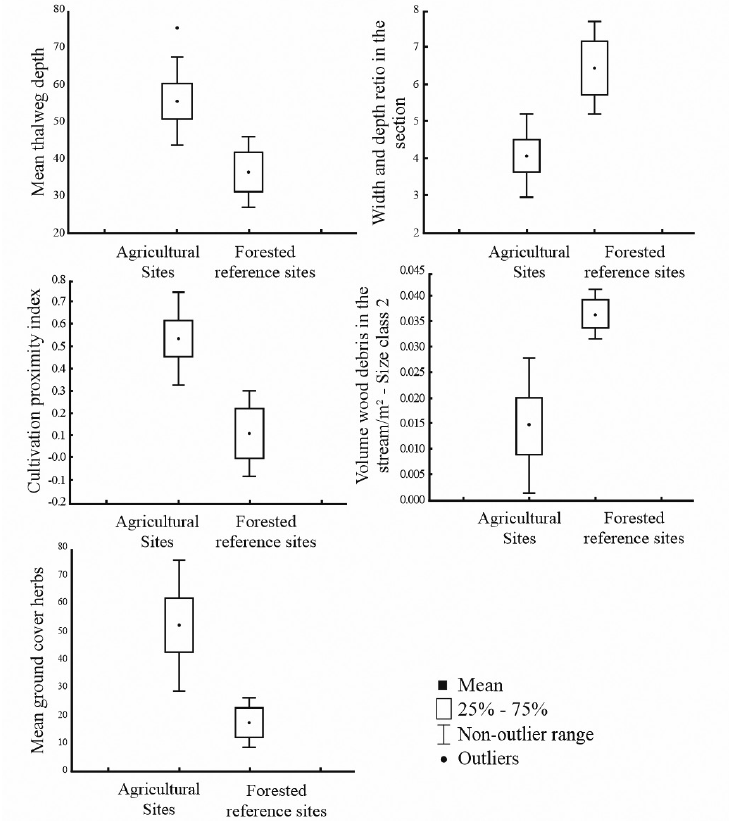
FIGURE 3 | Box-and-whiskers plots of the five metrics comprising the Physical Integrity